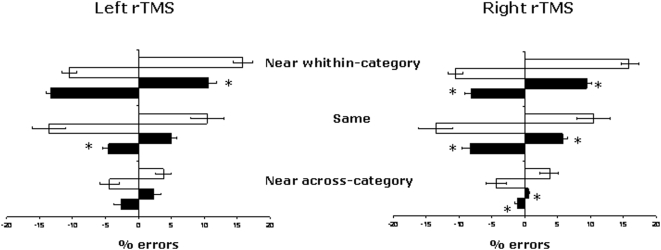
Experiment 5: Mean leftward and rightward errors (±1 SE) in the Semantic distance judgment task in the different experimental conditions.Negative values (black bars) indicate leftward shifts and positive values (white bars) rightward shifts in the judgment. White bars indicate leftward and rightward errors in baseline. Black bars indicate leftward and rightward errors in left rTMS (left panel) and right rTMS (right panel) sessions. rTMS = repetitive transcranial magnetic stimulation.